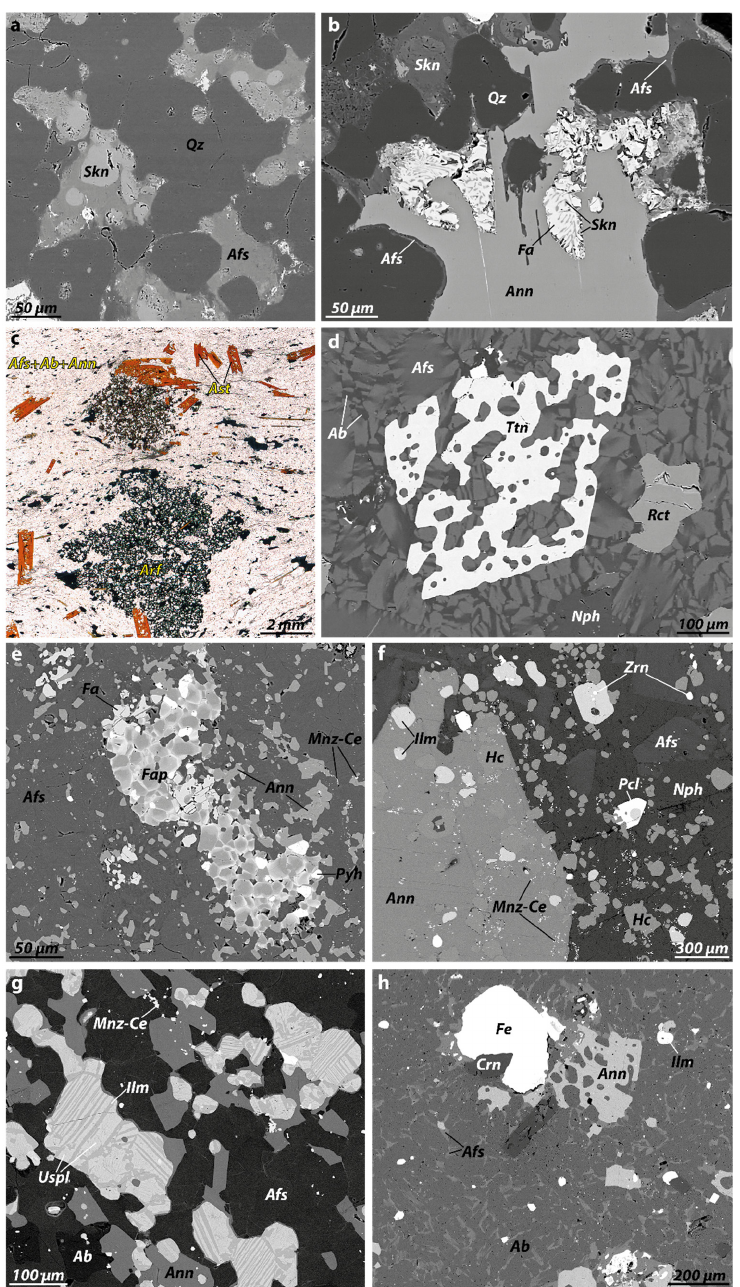
Figure 10. Mineral associations of quartzite and aluminous hornfelses. ( а ) sekaninaite grains located along the boundaries of quartz and (K,Na)-feldspar (quartzite, sample KH-110); ( b ) fayalite- sekaninaite intergrowths in annite grain surrounded by (K,Na)-feldspar rim (quartzite, sample КН - 111); ( c ) large poikilitic grains of arfvedsonite and astrophyllite among (K,Na)-feldspar (sample E-97-14); ( d ) poikilitic titanite crystal in fine-grained feldspar mass (sample LV-122); ( e ) zonal fluorapatite grains in fayalite-annite-feldspar hornfels (sample KH-61-6); ( f ) small grains of monazite- (Ce), and crystal of the pyrochlore-group mineral in nephelinized hercynite-annite-feldspar hornfels (sample M-01-1-10); ( g ) ulvöspinel grains with ilmenite lamellae in annite-feldspar hornfels (sample M-01-2-12); ( h ) native iron in corundum-annite-feldspar hornfels (sample KCH-05-31). BSE-images ( a , b , d – h ) and photo in transmitted light ( c